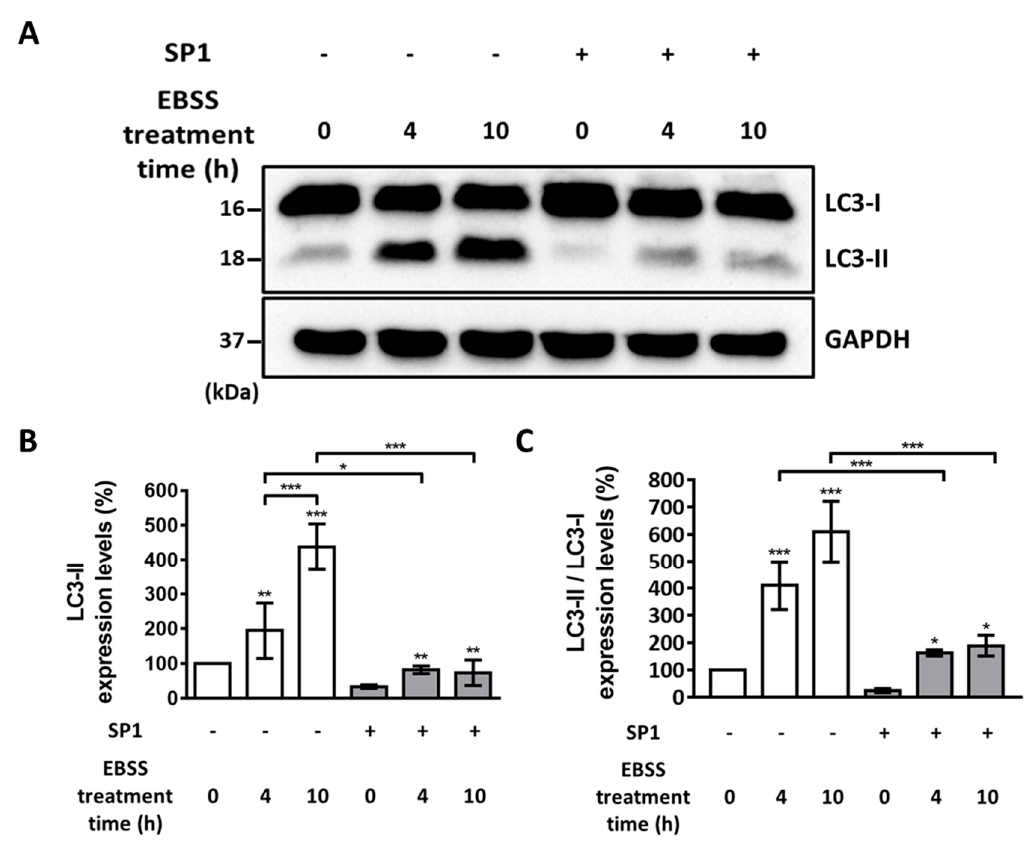
Figure 3. Western blotting analysis of LC3-I and LC3-II levels in the CHO cells before and after the EBSS treatment. ( A ) LC3-I and LC3-II protein levels were analyzed by performing Western blotting analysis. The cells were treated with EBSS for 0, 4, and 10 h. Glyceraldehyde 3-phosphate dehydrogenase (GAPDH) was used as an internal control. ( B ) Quantitative analysis of the results of Western blotting analysis are shown in ( A ) for LC3-II levels normalized using the GAPDH levels. Statistical analysis of data obtained from three independent experiments was performed using GraphPad Prism 7.0 software and ImageJ 1.43. ( C ) Quantitative analysis of the results of Western blot analysis shown in (A) for LC3-II levels normalized using LC3-I levels. All values are represented as mean ± SD (* p < 0.05, ** p < 0.01, and *** p < 0.001; n = 3).